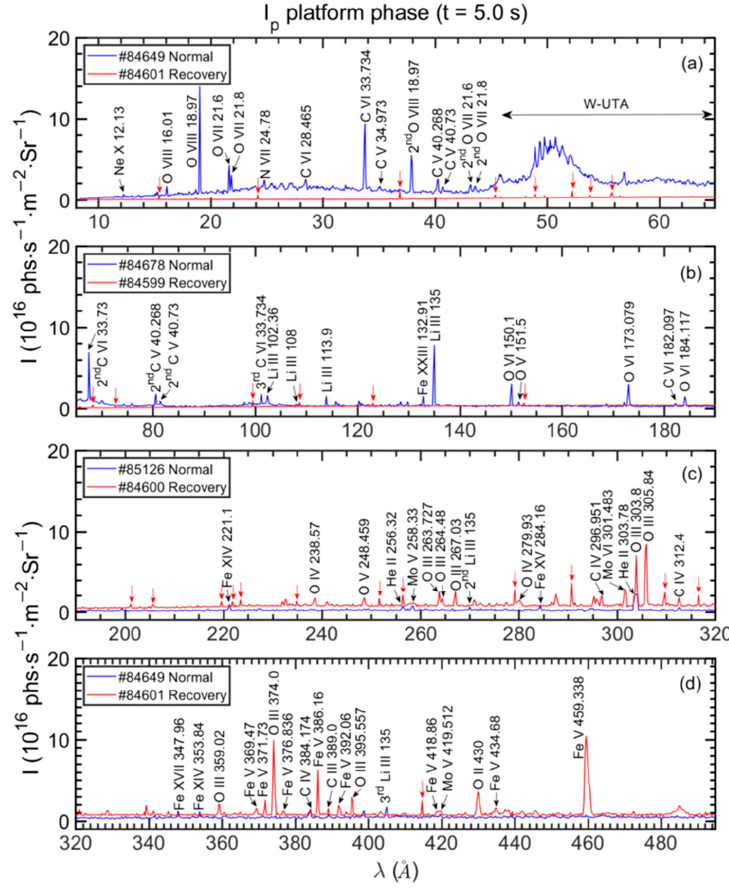
Figure 6. EUV spectra comparison during I p platform phase (t = 5.0 s) in recovery (red lines) and normal (blue lines) discharges. ( a ) 8–65 Å, ( b ) 65–190 Å, ( c ) 190–320 Å, and ( d ) 320–495 Å. Spike noise are indicated with red arrows.